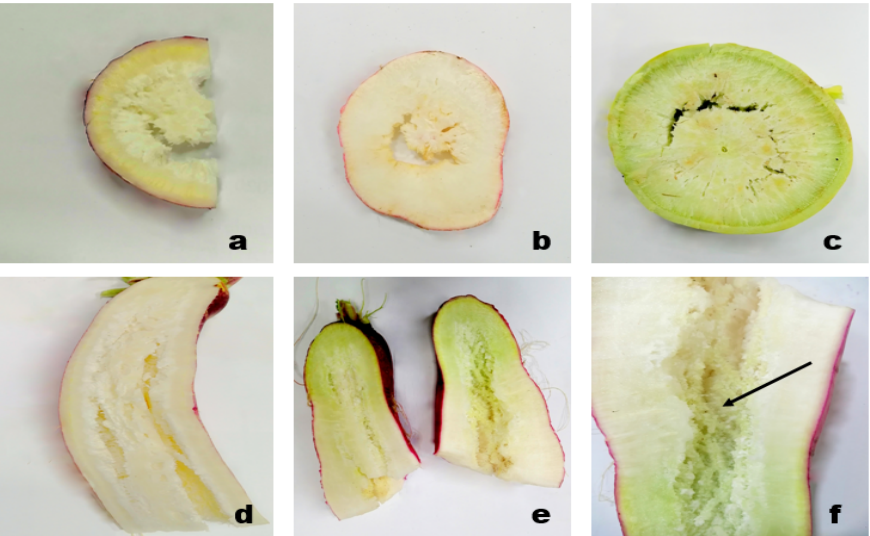
Figure 5. Hollow space formation in radish roots of different cultivars: cross section of hollowness in young roots (( a ): Black ball, ( b ): Bari red) cross section of over mature hollow roots (( c ): Green neck) longitudinal view of severe hollowness in young roots (( d , e ): Lalpari) close view of hollow space: formation of distorted cells represented by black arrow (( f ): Lalpari).